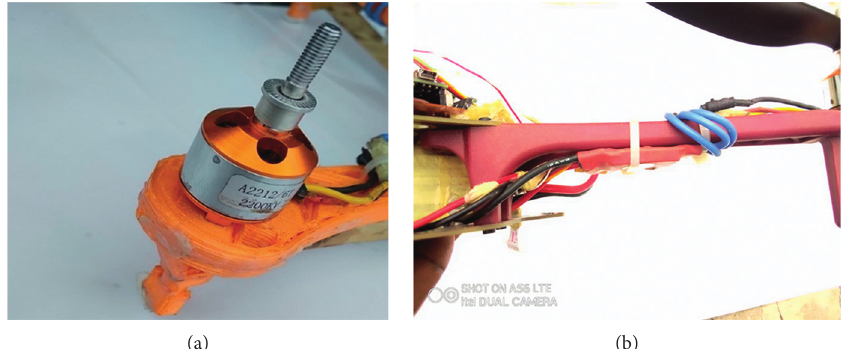
Figure 6: (a) Motor mounts. (b) Mounted motor.